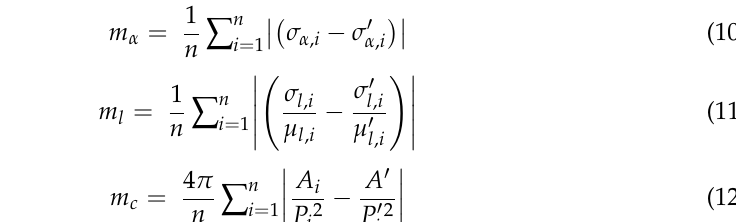
Figure 12. The corresponding triangles used for the quality